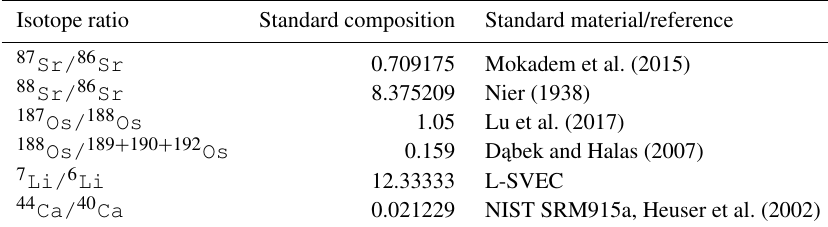
Table 5. Isotopic standards in